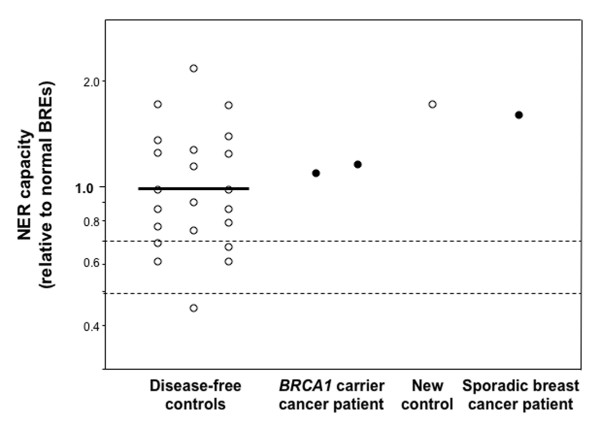
Comparison of the NER capacities of two samples of normal breast epithelium from our BRCA1 mutation carrier patient with those of a population of disease-free controls who underwent breast reduction mammoplasty. The dark horizontal line indicates the average for the normal population of breast reduction epithelium (BRE), while the dotted lines indicate upper limits for residual NER activity in patients with the hereditary NER deficiency disease XP (0.50) and the cut-off established in our breast tissue study that identified tumors with high sensitivity and specificity (0.70). The patient sample on the left was derived from the ipsilateral (left) breast, while the sample on the right was from the contralateral (right) breast.